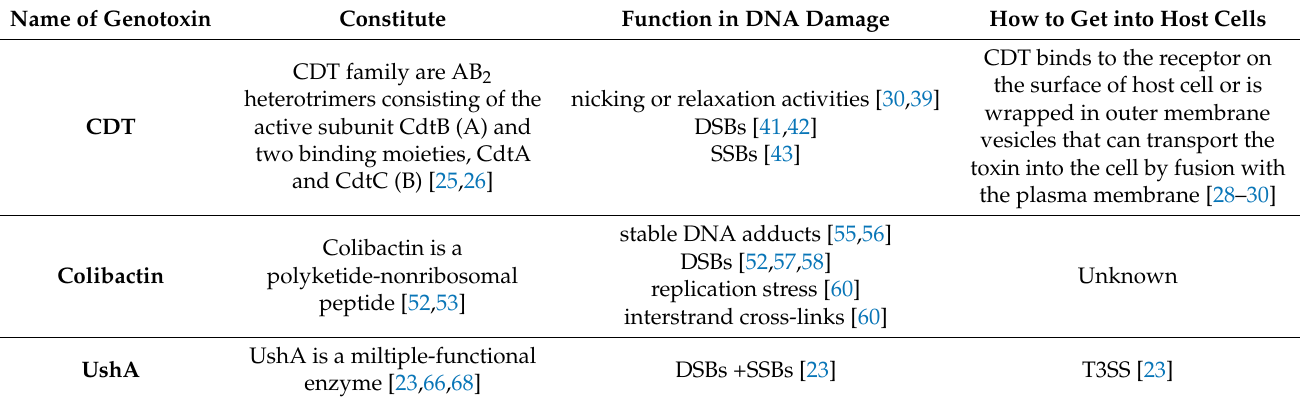
Table 2. The similarities and differences of E. coli -producing